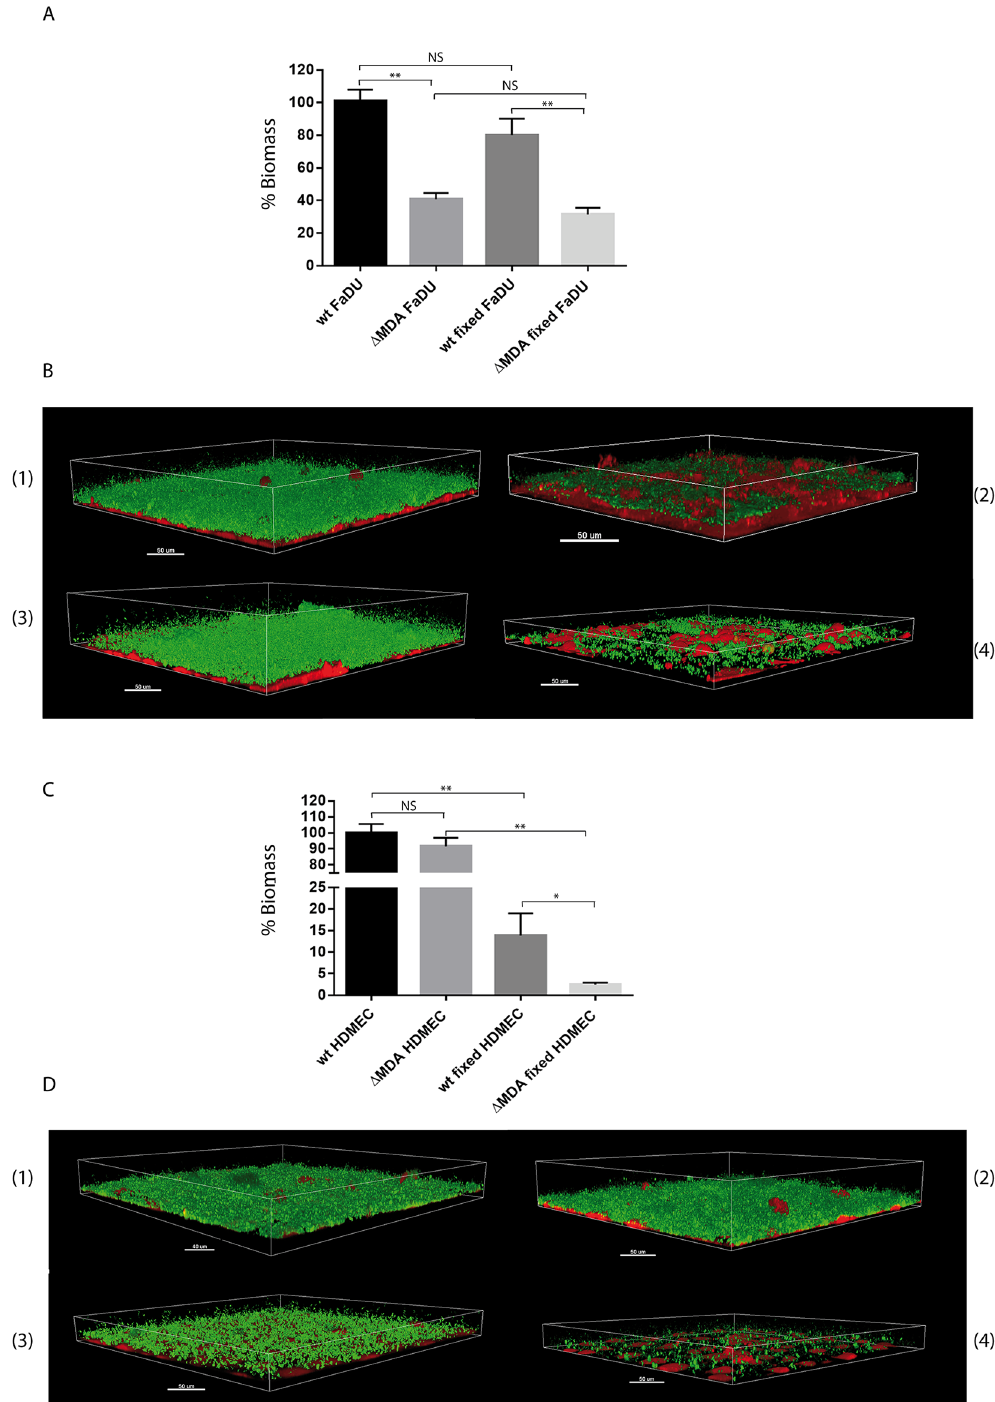
Fig 1. Colonization of cells by the wild type and prophage deleted strains. Quantificationof the biomasson living and paraformaldehydetreated epithelialcells (FaDu). Three-dimensional reconstruction of the biomassin (A) with the Imaris software. (1) Z5463 gfp (WT strain) on FaDu, (2) Z5463 gfp Δ MDA on FaDu, (3) Z5463 gfp (WT strain) on fixed FaDu, (4) Z5463 gfp Δ MDA on fixed FaDu. Bacteria are shown in green and epithelialcells in red. Quantification of the biomass on livingand paraformaldehyde treated endothelialcells (HDMEC). Three- dimensional reconstruction of the biomassin (C) with the Imaris software. (1) Z5463 gfp (WT strain) on HDMEC, (2)